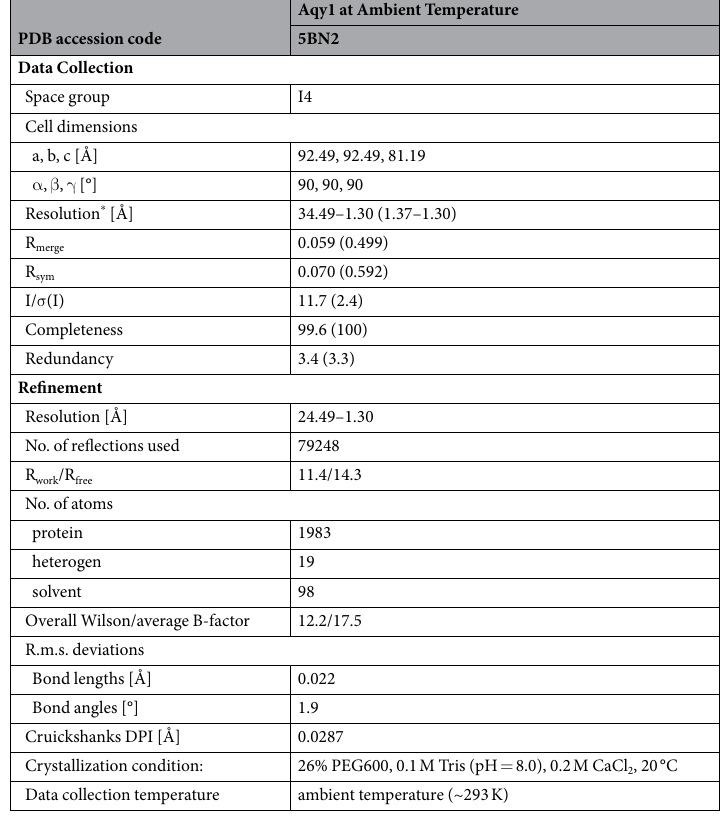
Table 1. Crystallographic data collection and refinement statistics. * Values in parenthesis are given for the highest resolution